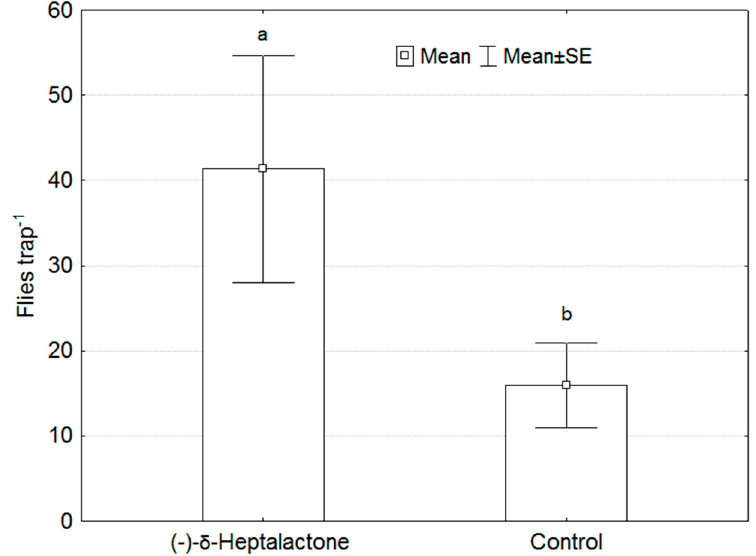
Figure 7. Field catches of Rhagoletis batava in McPhail traps. Different letters indicate statistically significant difference (general linear model, F = 7.013, p = 0.027); intervals mark SE; n = 3 for each type; trapping period lasted from 30 July to 20 August 2019.